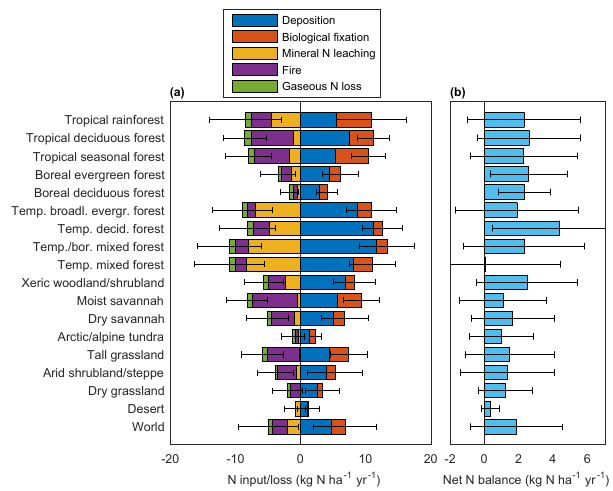
Figure 2. Ecosystem N budget per biome for the true historical simulation ( + Ndep + clim + CO 2 ) averaged over the period 1997– 2006. (a) Mean N input and loss fluxes. (b) Mean net ecosystem exchange of N. Organic N leaching (not shown) is negligible for all biomes. Error bars indicate 1 standard deviation among area- weighted grid cell averages for the target time